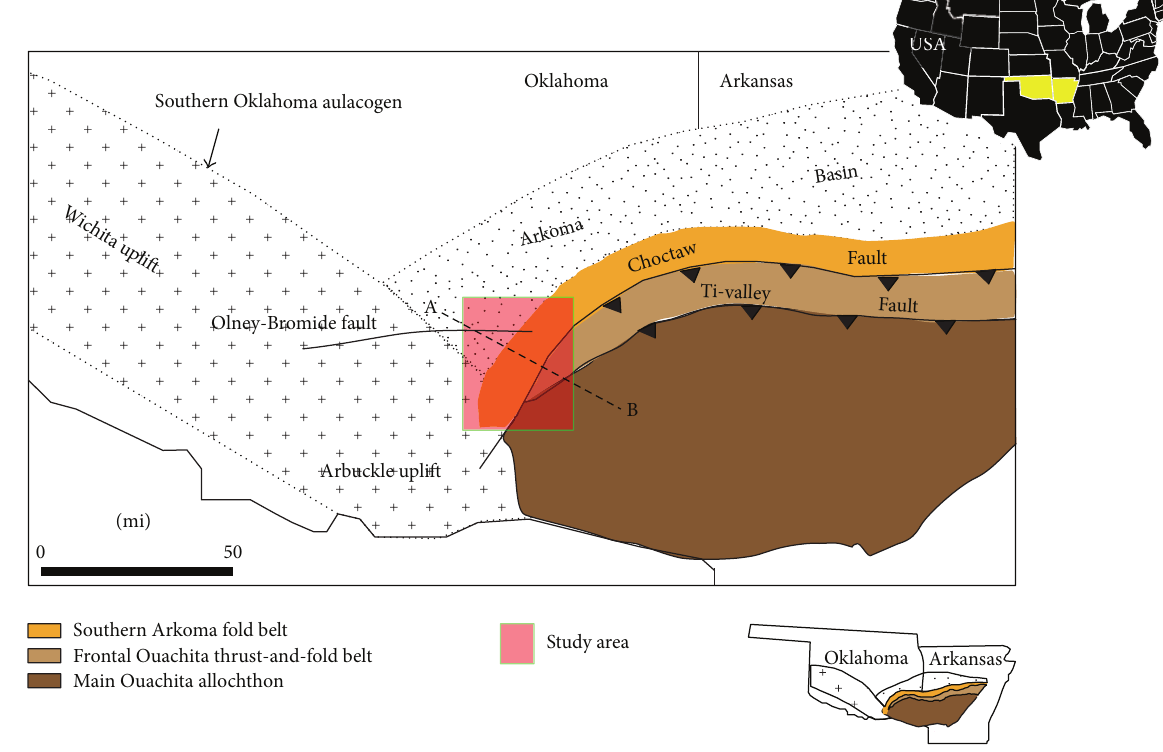
Figure 2: Location map of the Arkoma Basin